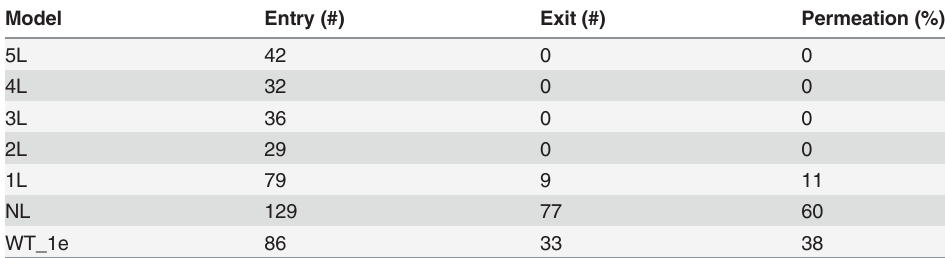
Table 2. Ion flux (K + ) through the engineered MscL